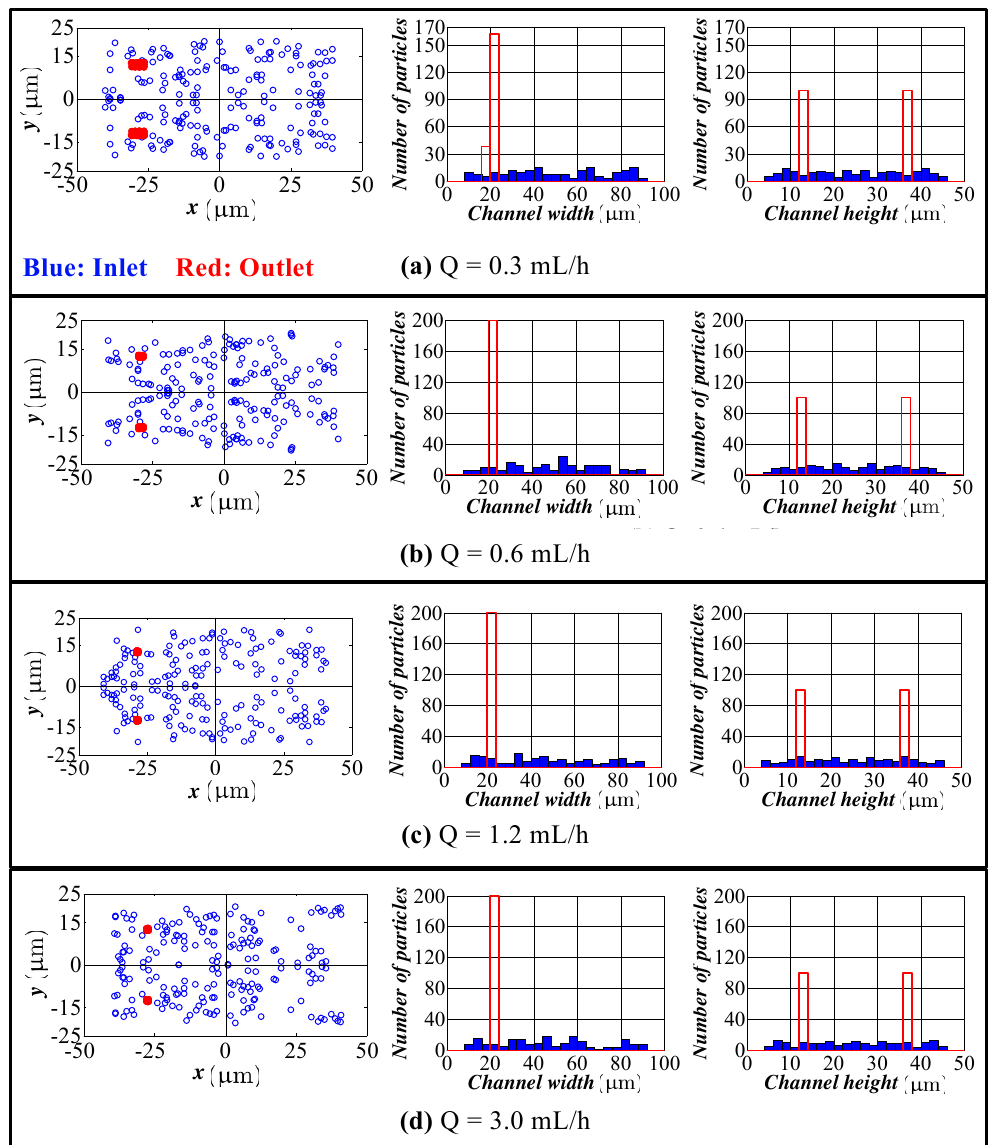
Figure 4. Particle distribution at the inlet and outlet in the height and width directions for different flow rates (spiral channel with an AR 2.0, 7.2 µ m particles). Flow rate: ( a ) 0.3 mL/h; ( b ) 0.6 mL/h; ( c ) 1.2 mL/h; ( d ) 3.0 mL/h. Blue bars: particle distribution at the inlet. Red bars: particle distribution at the